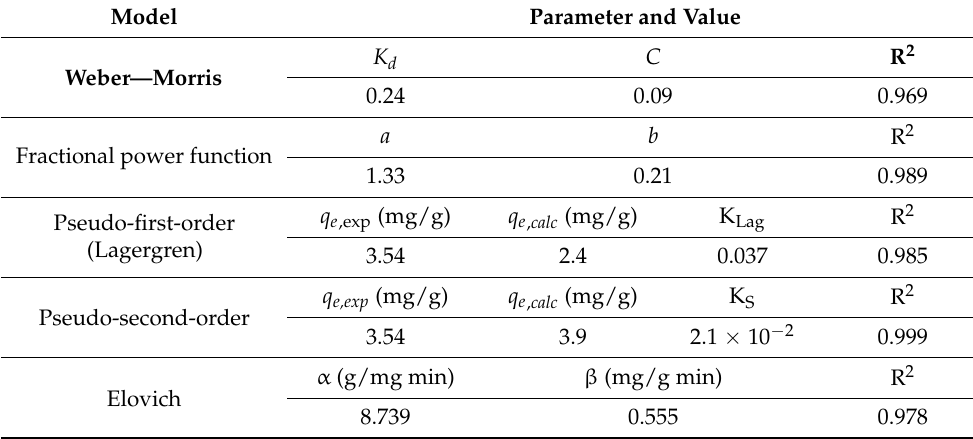
Table 2. Kinetic model parameters of Ceph adsorption on HAP at 293 K.